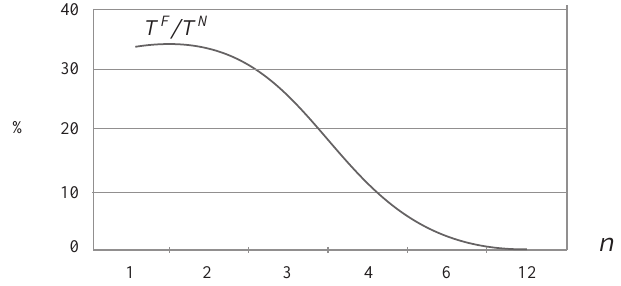
Fig. 2. Dependence of construction duration on the number of combined